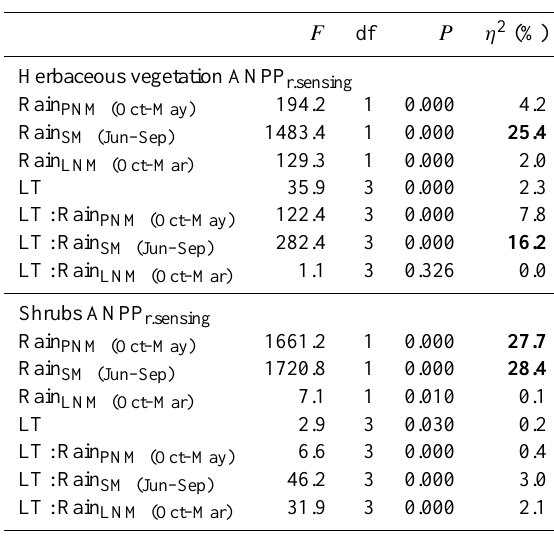
Table 1. Main effects and interactions of seasonal precipita- tion (preceding non-monsoonal rainfall, October–May; monsoonal summer rainfall, June–September; late non-monsoonal rainfall, October–March), and landscape type (four levels: grass-dominated, grass-transition, shrub-transition, and shrub-dominated landscapes) on remote-sensing-estimated annual (per growing cycle, April– March) net primary production for herbaceous vegetation and